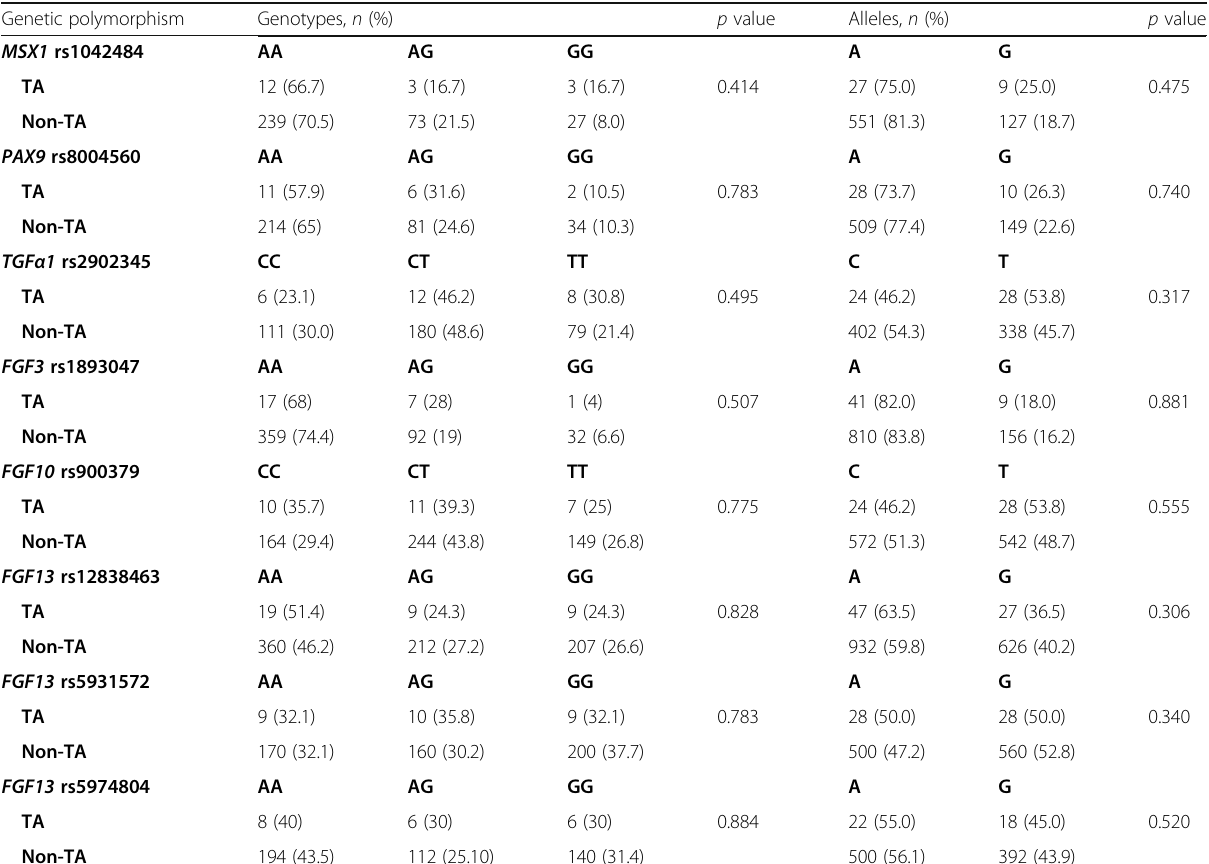
Table 2 Genotype and allele distribution between TA and non-TA participants Genetic